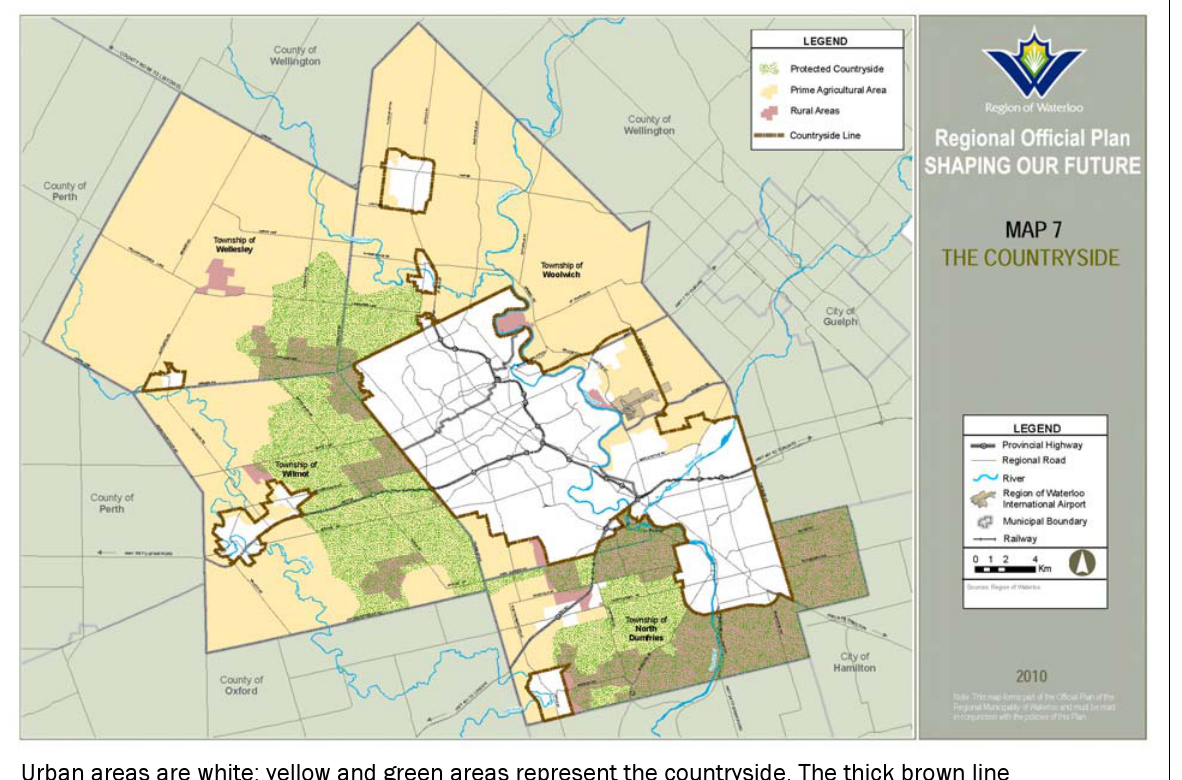
Urban areas are white; yellow and green areas represent the countryside. The thick brown line surrounding the white areas is the Countryside Line. The green area surrounding the southern and western side of the three cities is designated as the Protected Countryside. Where the Countryside Line abuts the Protected Countryside, the Countryside Line is to be considered a permanent growth boundary. In all other areas, the Countryside Line is considered a long-term urban